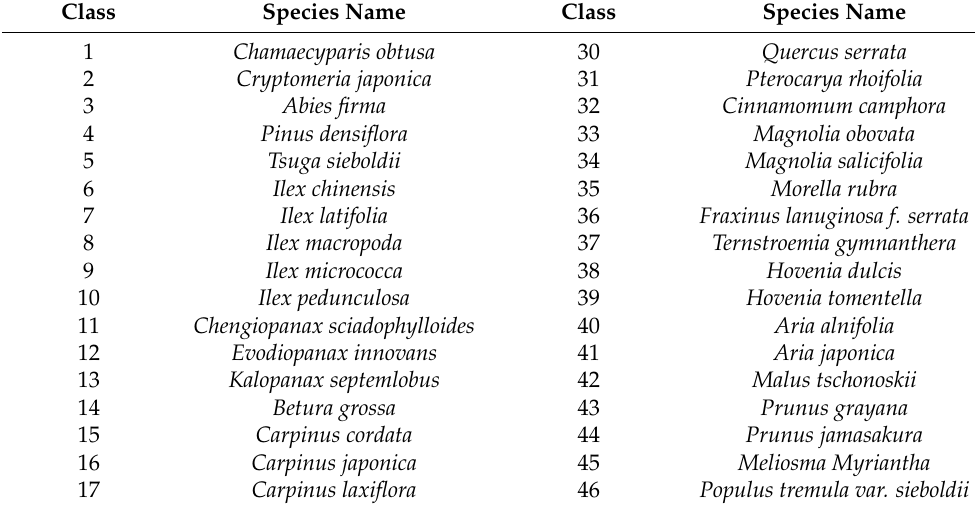
Table 2. Tree species list of training data which was identified in UAV imagery from the field